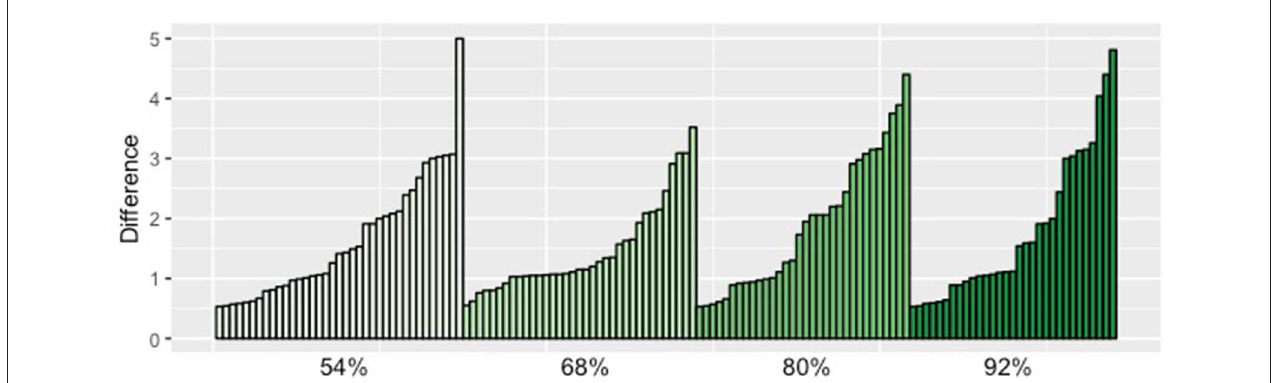
FIGURE 6 | This plot depicts the difference between contrastive and non-contrastive condition (on the Y axis) for each of the 135 participants of the Con group (on the X axis). We grouped the participants by the proportion that they saw. We can see that it is not the case that there are mostly higher scores for higher proportions. NB: each participant saw only one